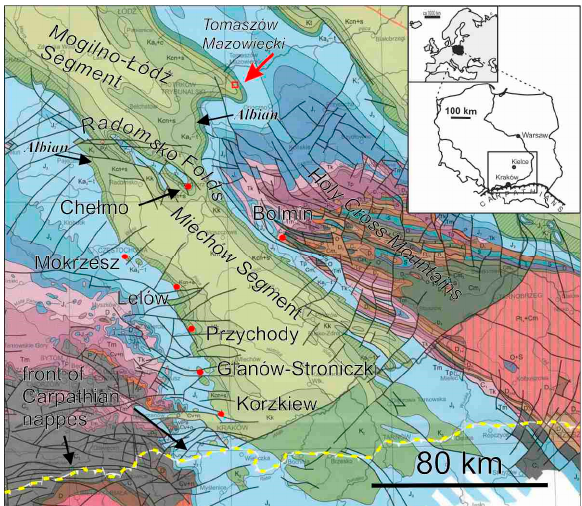
Figure 1. Geological map of the Miechów Segment (southern part of the Szczecin–Miechów Synclinorium) and adjacent areas, southern Poland [11]. Standard stratigraphic colours were used: green—Cretaceous; blue—Jurassic; violet-pink—Triassic; other colours—pre-Mesozoic. Red dots indicate sample localities. Red arrow indicates the mined area for glass industry raw material (informal name Bia ł a Góra deposit) near Tomaszów Mazowiecki, yellow dotted line shows front of Carpathian nappes.